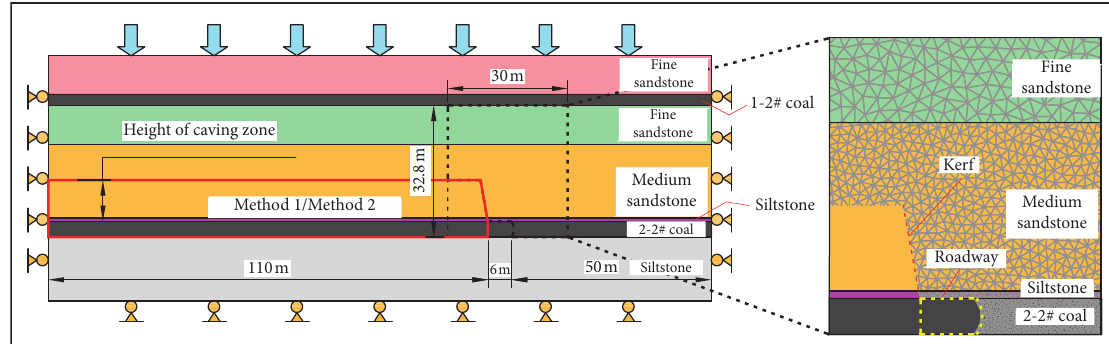
Figure 6: Numerical computation model.